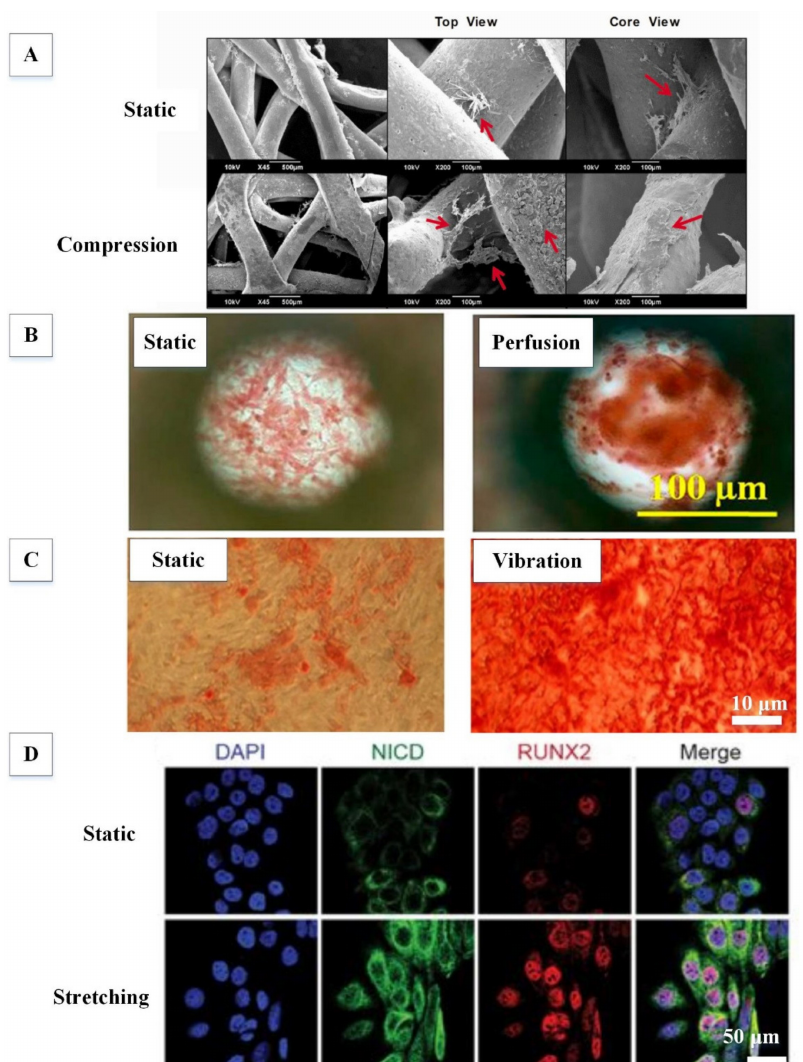
Figure 2. E ff ects of mechanical loading on the osteogenesis of human mesenchymal stem cells (hMSCs). ( A ) Dynamic compression improved bone mineralization. Red arrows show mineral deposits. Adapted with permission from [26] © John Wiley & Sons (2017). ( B ) Perfusion enhanced calcium